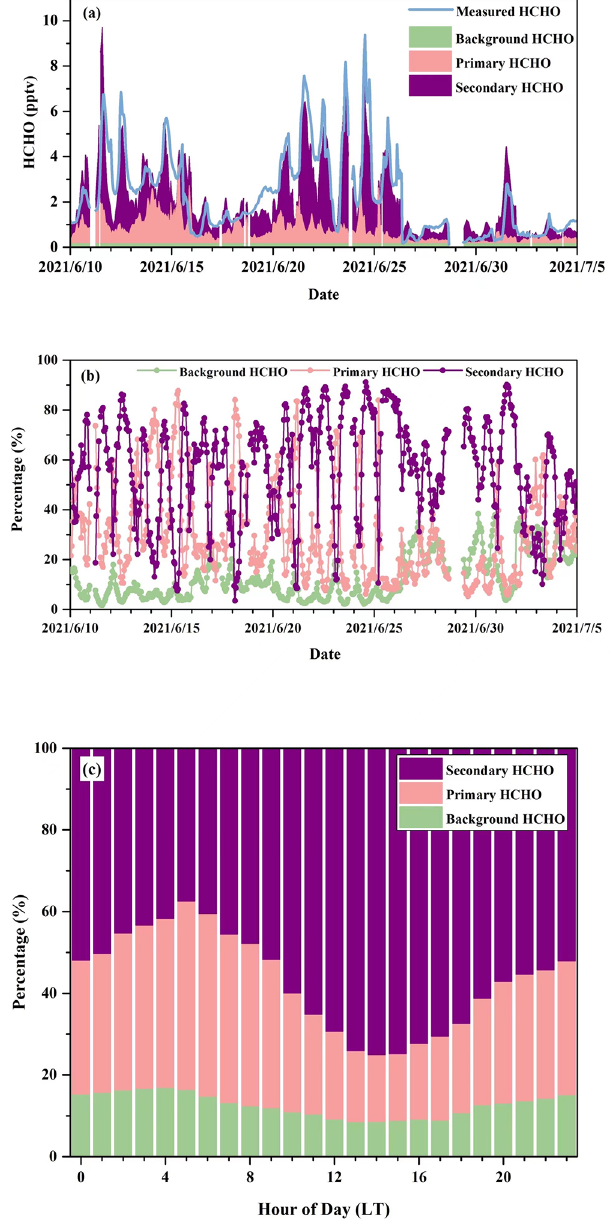
Figure 4. (a) Time series and (b) relative contributions of back- ground, primary, and secondary sources to HCHO from a multi- linear regression model during the campaign and (c) campaign- average diurnal contributions of background, primary, and sec- ondary